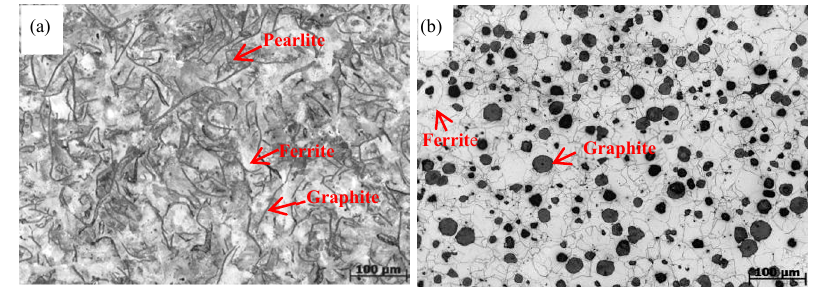
Figure 6. The microstructure of two materials: ( a ) HT250 and ( b ) QT450.